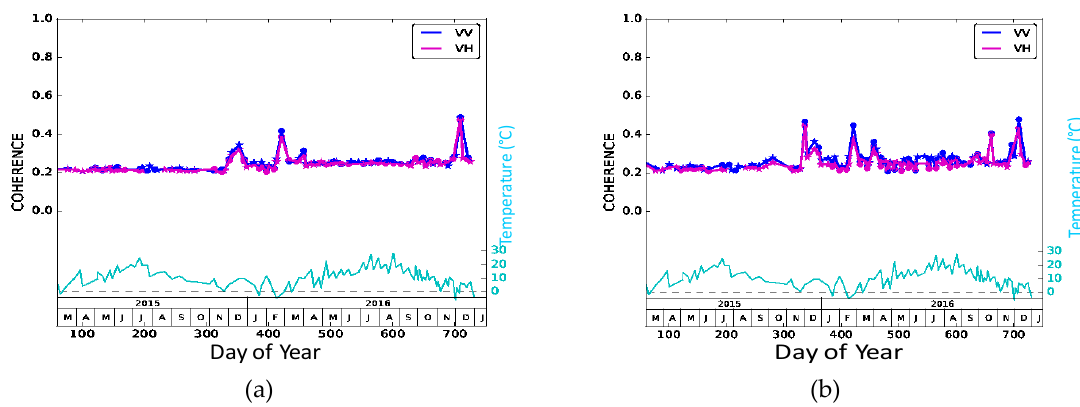
Figure 7. Temporal profiles of | ρ | observed over an oak ( a ) and a pine ( b ) stand with VV and VH polarization. In situ temperatures at 2 m are also shown (cyan).